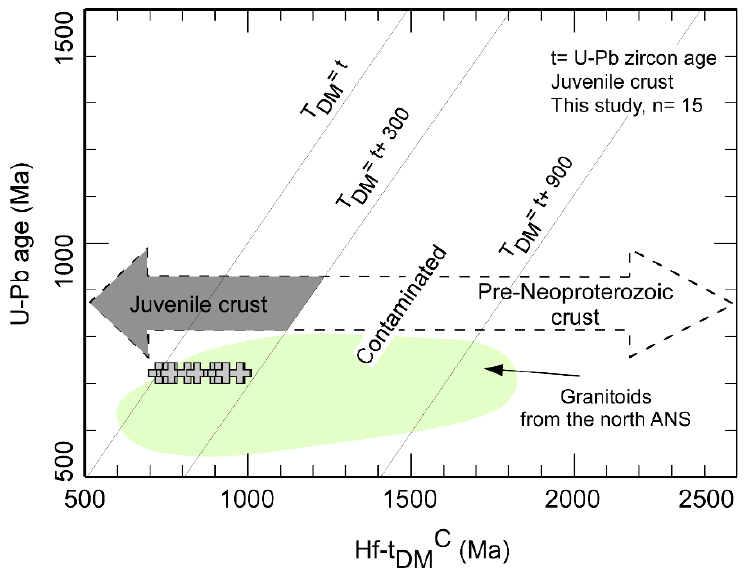
Figure 8. Plots of U–Pb zircon ages versus Hf crustal model ages (Hf ‐ t DMC ) (modified after Hargrove et al. [53]) for zircons from the Haweit granodiorite. Crustal model ages (t DMC ; Table 3) were calculated assuming that the parental magma of the zircons was produced from an average continental crust ( 176 Lu/ 177 Hf = 0.010) [54]. Data yielding Hf ‐ t DMC = t (U ‐ Pb zircon age) or Hf ‐ t DMC < t are considered to represent a juvenile source, whereas those with t + 300 < Hf ‐ t DMC < t + 900 or with Hf ‐ t DMC > t + 900 are considered to represent juvenile crust contaminated by pre ‐ Neoproterozoic crustal components.